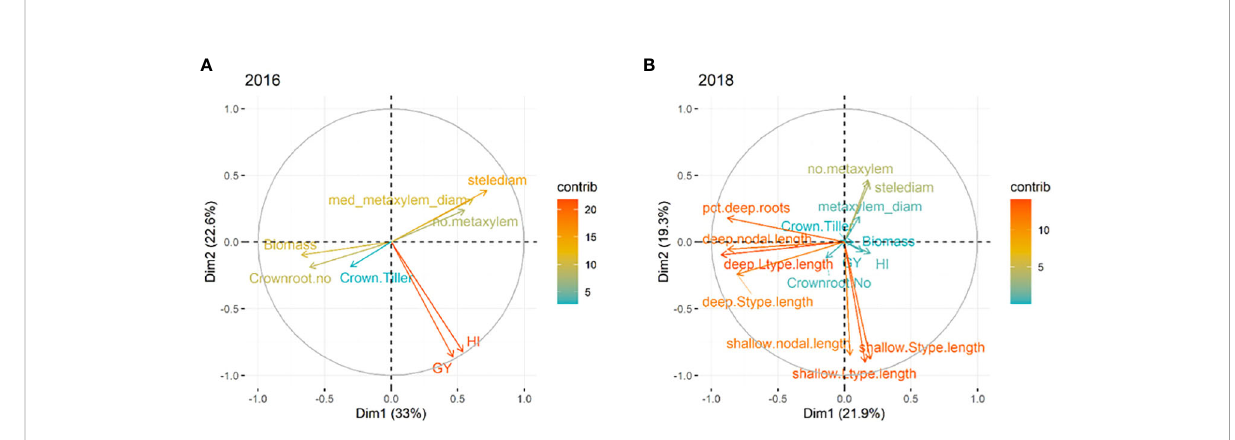
FIGURE 3 Principal components analysis of phenotypes in (A) agronomic, root anatomical and morphological phenotypes in puddled, transplanted (2016WS; left) and (B) direct seeded (2018WS; right) trials on the Thai/SE Asia panel. WS, wet